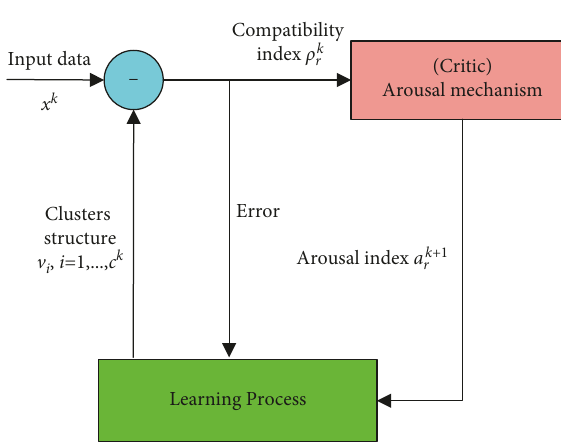
Figure 2: Participatory